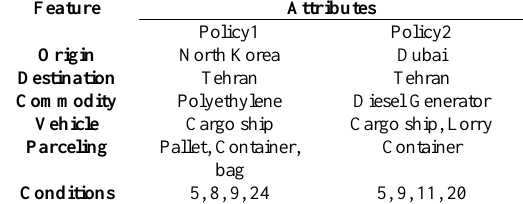
Table 1. Two different sample policies and their